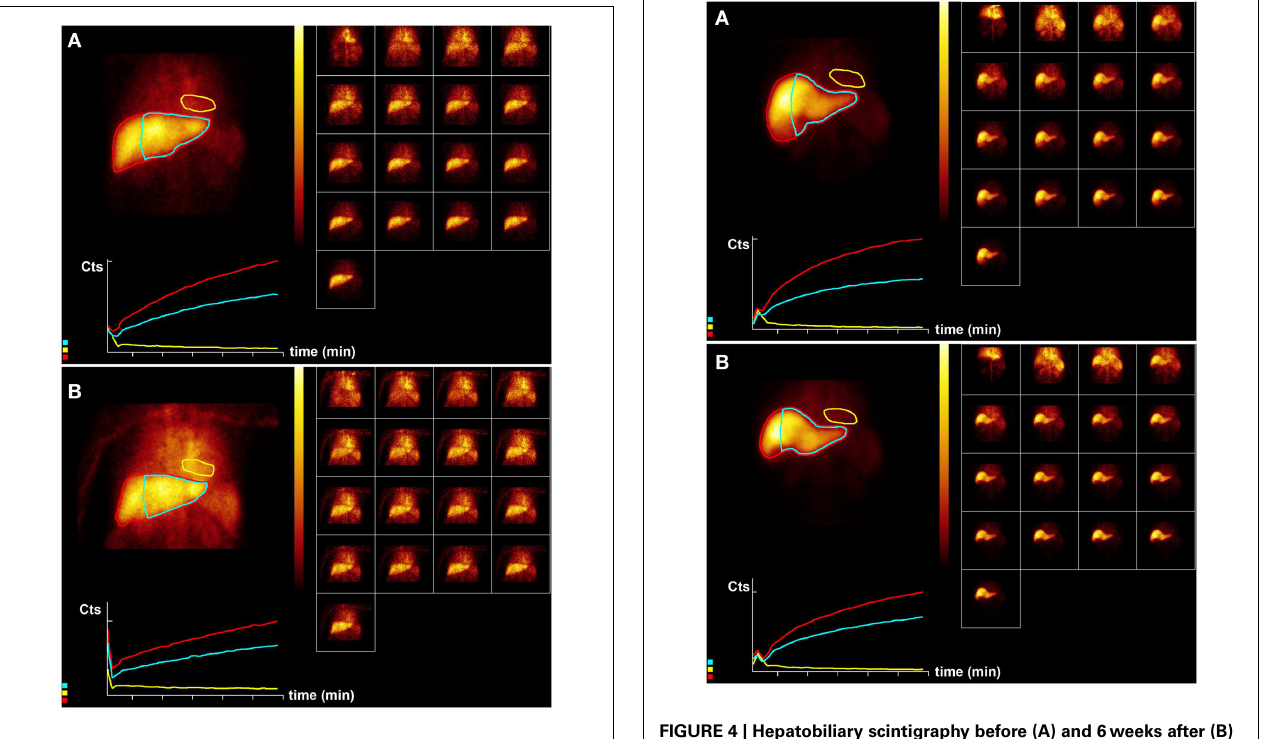
FIGURE 3 | Hepatobiliary scintigraphy before (A) and 6weeks after (B) a second treatment (6-month interval) with 1.5GBq 90 Y labeled SIR-Spheres in a 65-year-old male patient with multifocal predominantly right-sided recurrent hepatocellular carcinoma (Figure 1) . Displayed are summed dynamic frames (2 × 10s/frame), a summed image (20 × 10s) with regions of interest drawn around the entire liver (red), left liver segments 2–4 (blue), and cardiac blood pool (yellow), and corresponding time–activity curves.The total liver function (body surface area corrected mebrofenin uptake rate) was reduced after treatment from 4.8 to 2.2%/min (red curves).This time, function of left liver lobes 2–4 decreased proportionally from 3.2 to 1.6%/min (blue).The patient was diagnosed with radiation embolization induced liver disease.